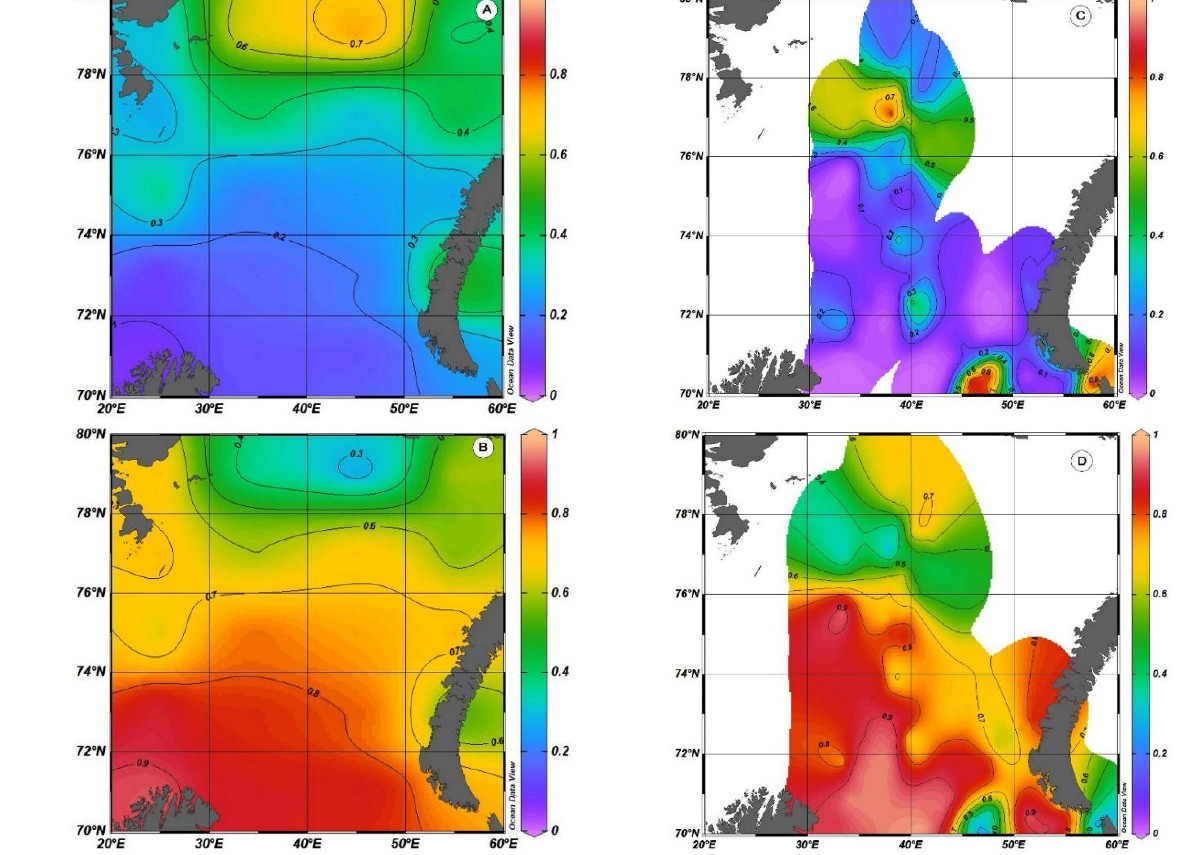
Figure 5. Relative values of total sum diatoms “d” ( A ) and dinoflagellates “p” ( B ) contribution to the total production (calculated values Equation (16)). Relative contribution diatoms ( C ) and dinoflagellates ( D ) to the total phytoplankton biomass (direct measurements), July — September.